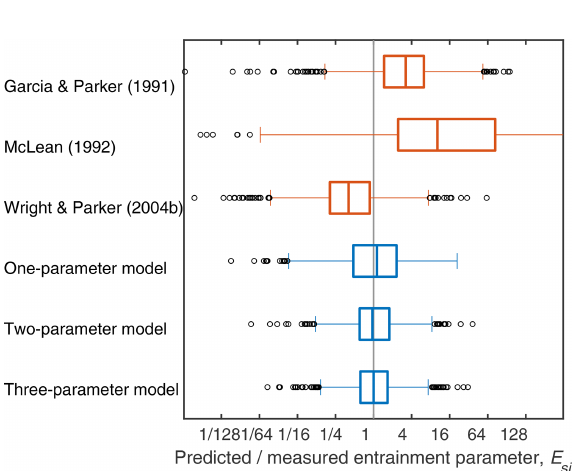
Figure 9. Box plot of predicted versus measured entrainment pa- rameters, E s i , for our models and previous models. The best-fit one-, two-, and three-parameter models correspond to the equations in bold in Table